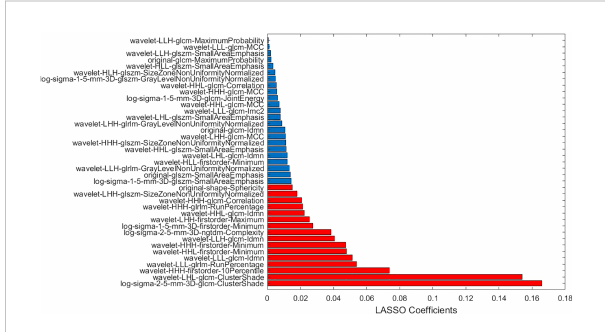
FIGURE 4 The non-zero coef fi cients in dl-LASSO and the selected features by dl-LASSO (red